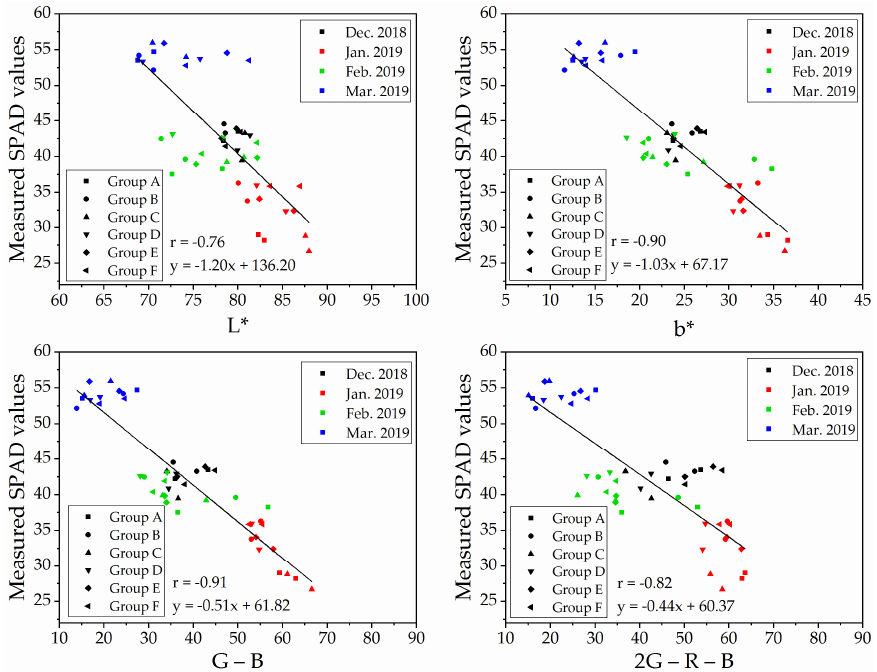
Figure 8. Relationships between measured SPAD values and UAV images (with vegetation extraction but without naked barley ear masked)-derived vegetation indices at the flight height of 50.0 m (n = 48). Table 5. RMSE (NRMSE) of the validation for SPAD values estimation with vegetation indices derived from UAV images. Vegetation Indices